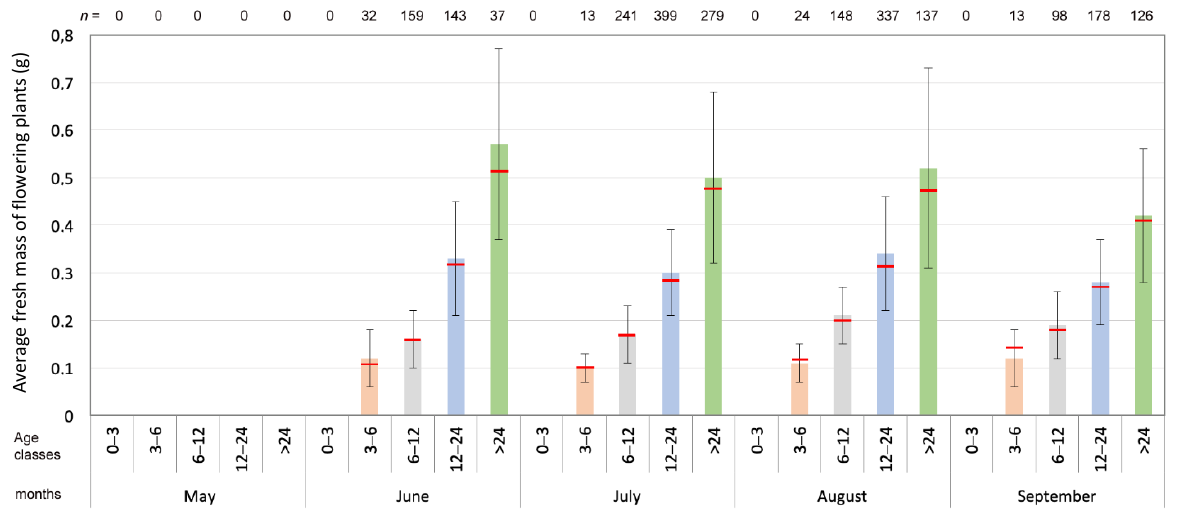
Figure A5. Fresh biomass of individual flowering Drosera rotundifolia plants collected between May/June and September in 2013 and 2014 on the Sphagnum palustre and Sphagnum papillosum fields, ordered by age class (0–3, 3–6, 6–12, 12–24, >24 months). Vertical bars show the means, the red lines medians and the whiskers standard deviation. Number of replicates ( n ) is written above each